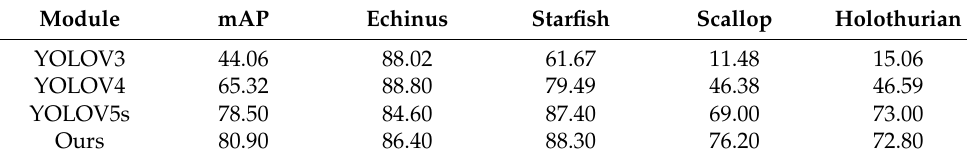
Table 1. Average Precision of each model on the underwater dataset